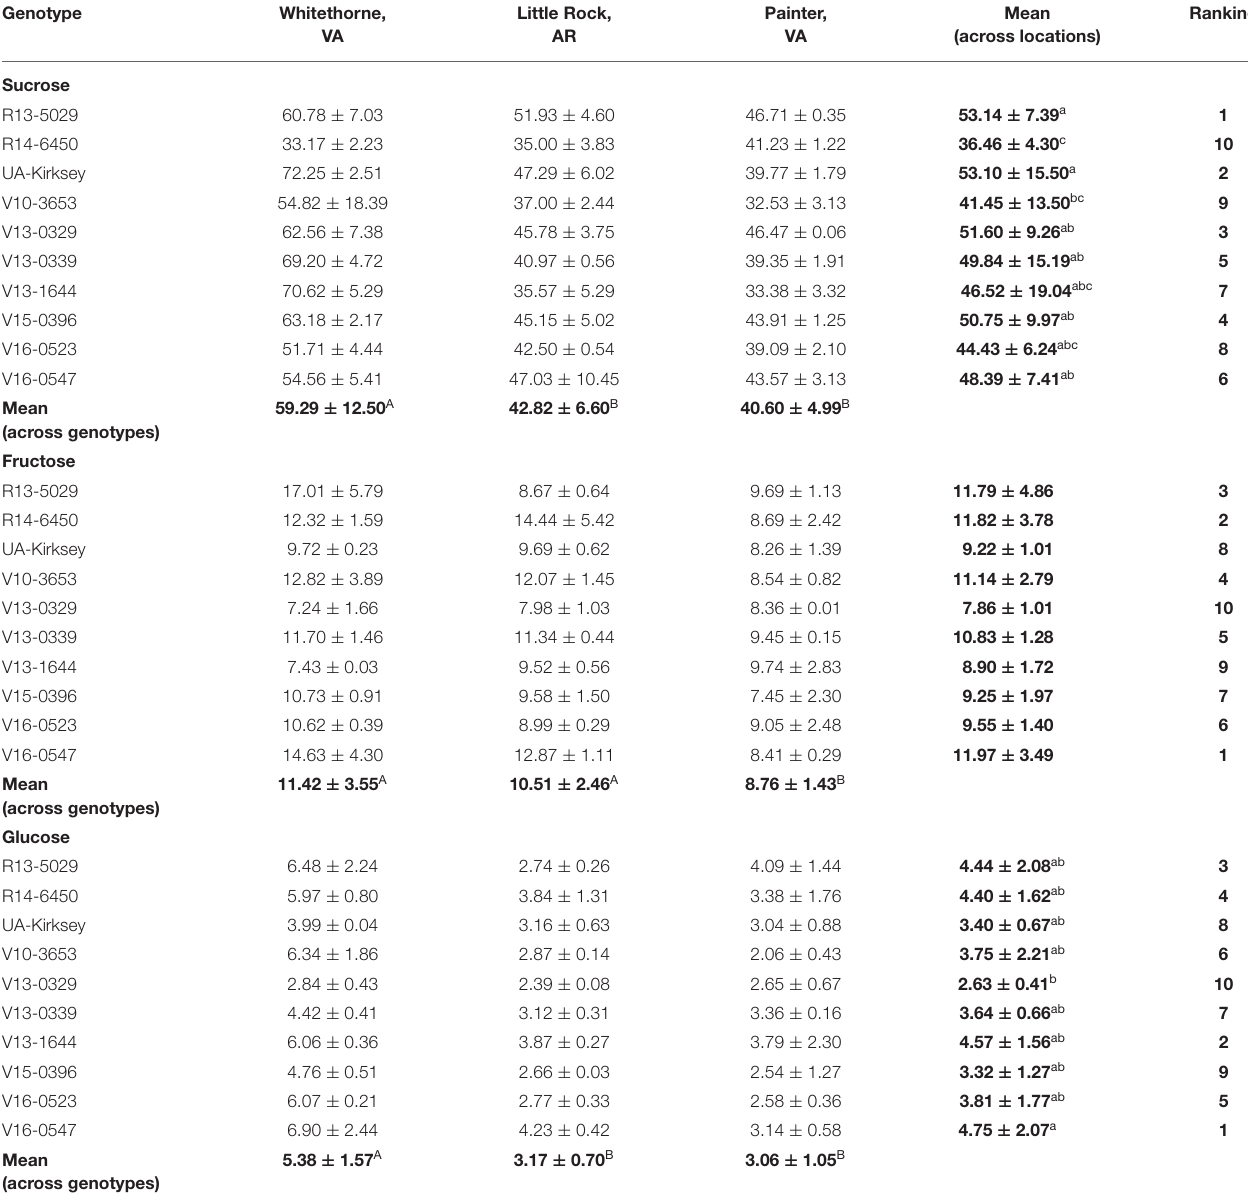
TABLE 2 | Sucrose, fructose, and glucose contents (mg/g dry matter) of 10 edamame genotypes planted in three locations. Genotype Whitethorne,